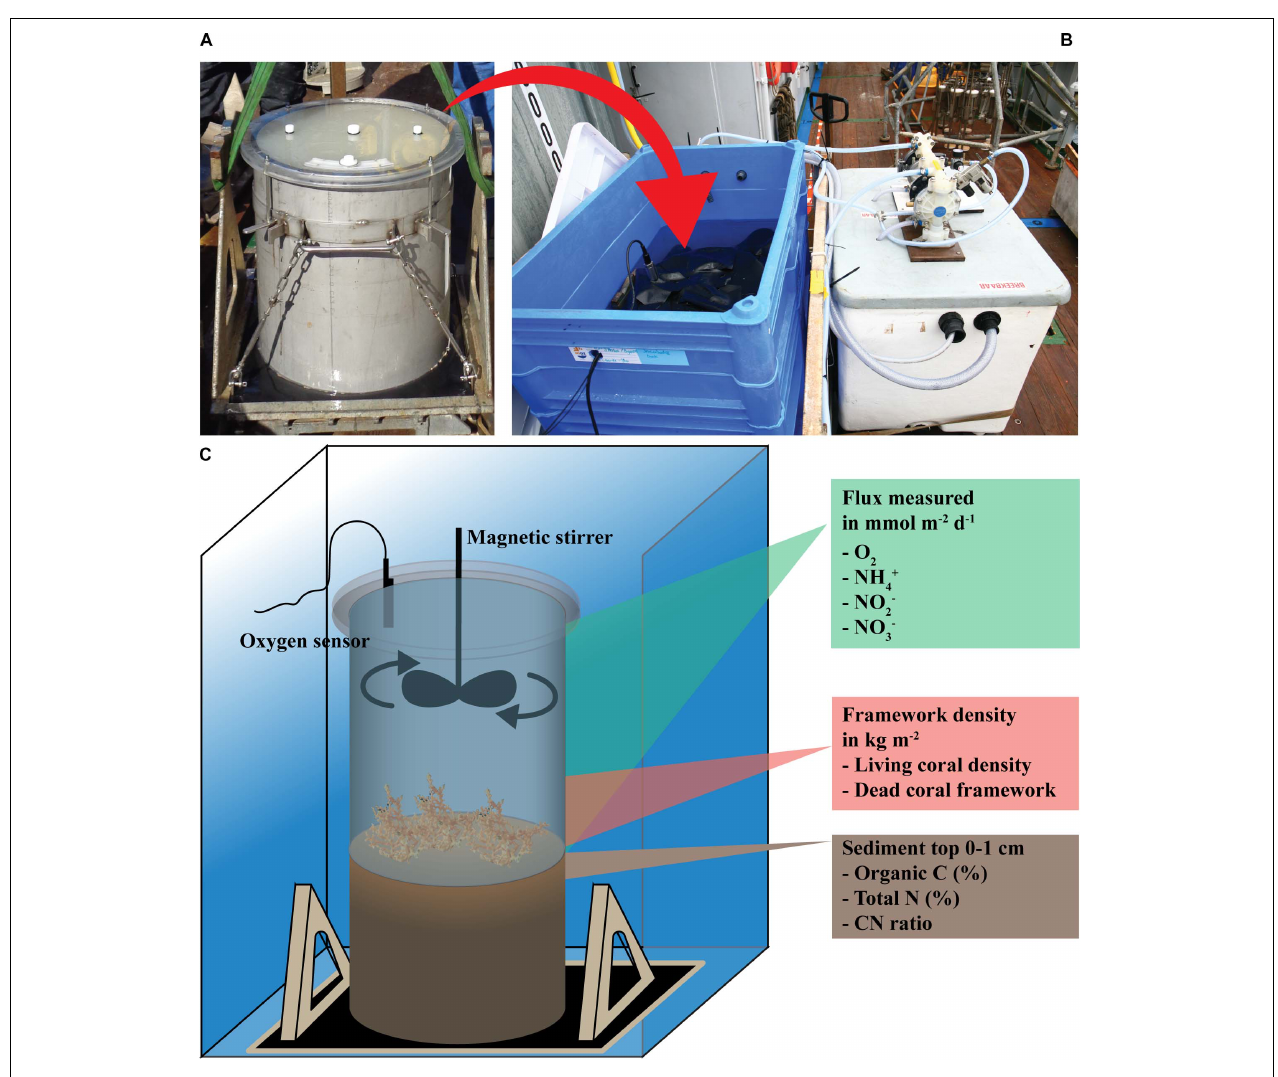
FIGURE 3 | (A) Box core after closure with lid, (B) incubation set-up, (C) schematic view of incubation set-up and measured variables.